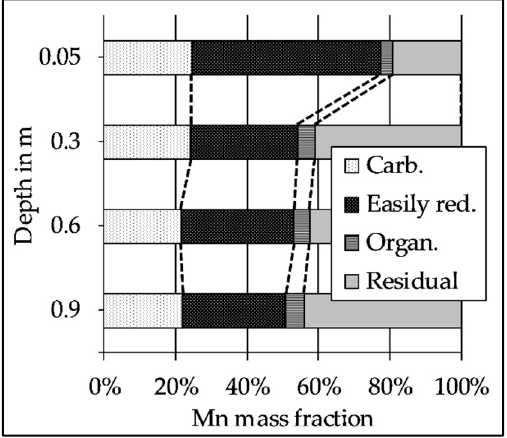
Figure 6. The median values ( n = 3) of the absolute Mn mass fractions along the column.